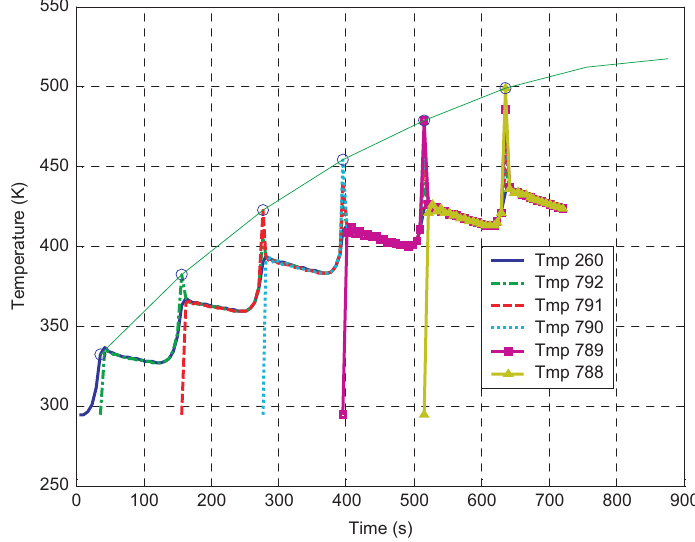
Figure 12 Temperature change at nodes 260, 792 – 788 along radial direction at the angle of 103.5 ° during 720 s (i.e., six rotations at 0.5 rpm), these nodes are shown in Figure